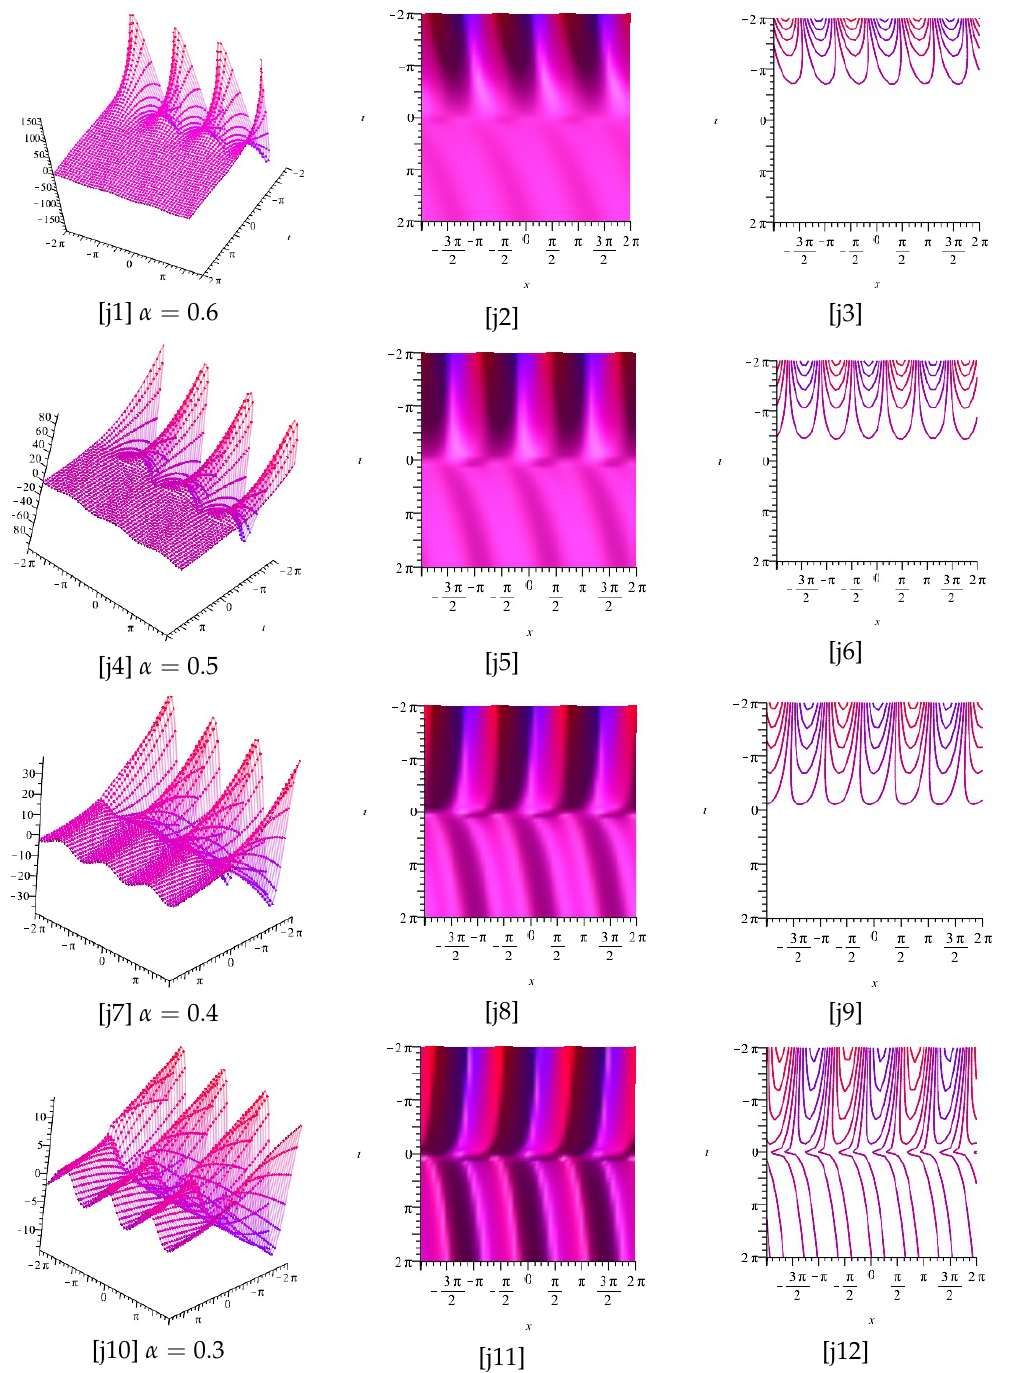
Figure 10. Now, [j1], [j4], [j7], [j10] display the plots of the imaginary part of Equation (34), for λη > 0, and [j2], [j5], [j8], [j11] as well as [j3], [j6], [j9], [j12] display the z -axis orientation and the contour plot,